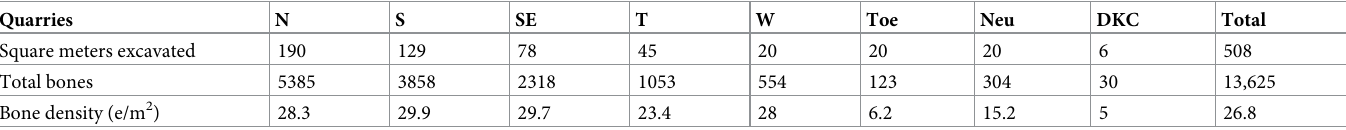
Table 1. Bone densities (e/m 2 ) in the five main (North (N), South (S), Southeast (SE), Teague (T), West (W)) and three exploratory quarries (Toe (T), neufeld (Neu), DKC).